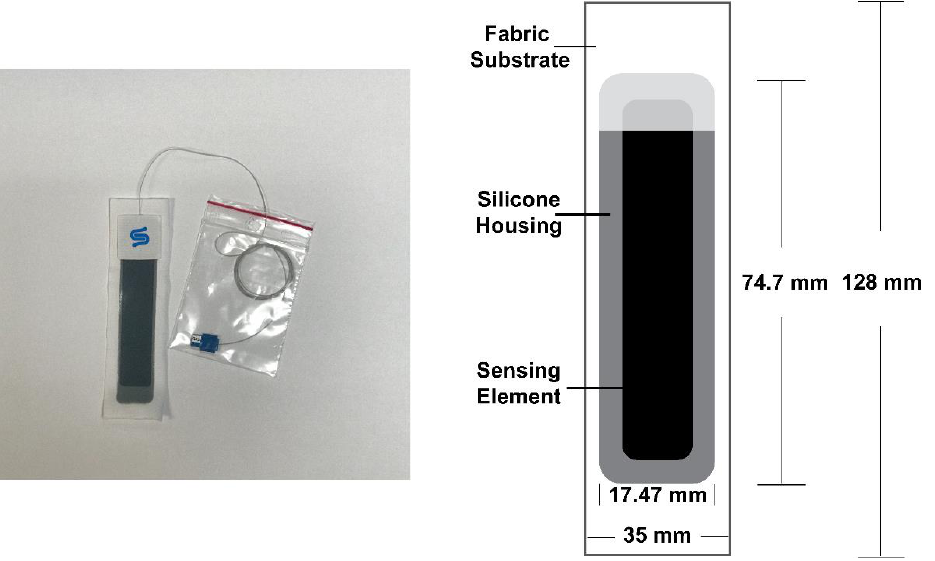
Figure 3. The StretchSENSE™ StretchFABRIC sensor is comprised of a proprietary sensing material that is encapsulated in silicone and attached to a fabric substrate. The sensor inclusive of the fabric substrate has a length of 128 mm, a width of 35 mm, and a thickness of 0.56 mm. Exclusive of the fabric substrate, the sensing element and its silicone housing have a length of 74.7 mm and a width of 17.47 mm. The fabric substrate is represented by the white rectangle, the silicone housing by the grey rectangle, and the sensing element is represented by the black